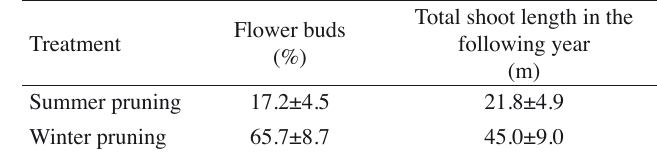
Fig. 9 - Effect of summer pruning on the regenerated shoot length of peach trees. Data are presented as mean ± standard error ( se ).